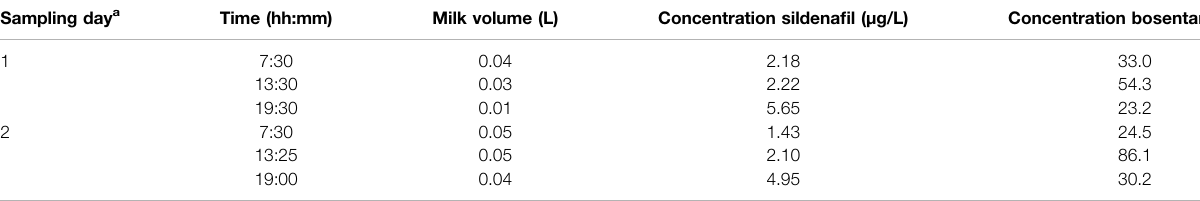
TABLE 2 | Overview of the timing and volume of collected milk samples along with milk concentrations of sildena fi l and bosentan. Sampling day a